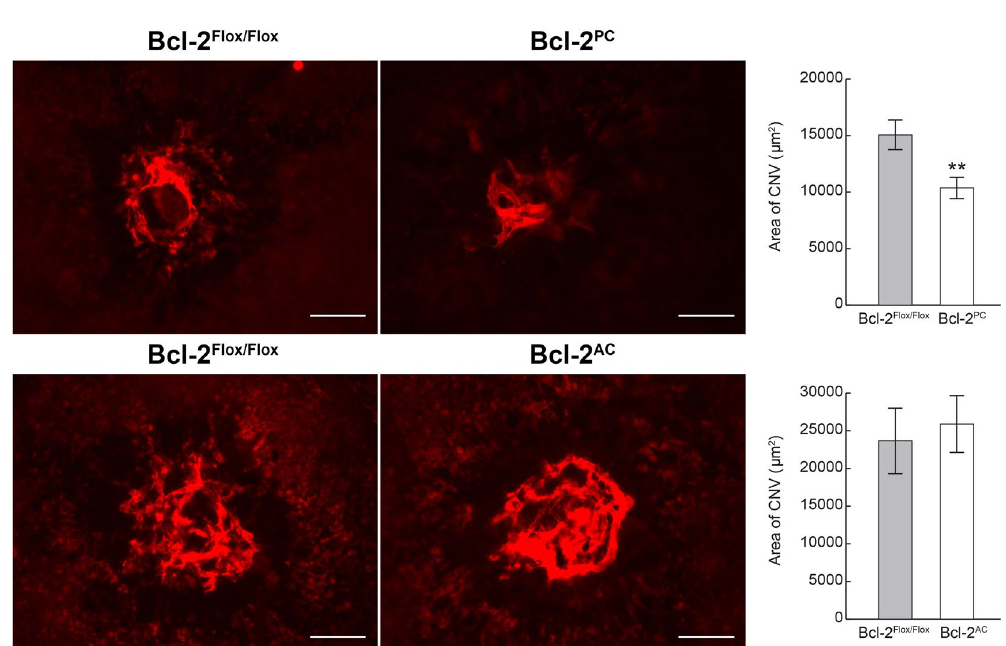
Figure 8. Lack of Bcl-2 expression in pericytes attenuates choroidal neovascularization. Six-week old mice underwent laser photocoagulation-induced rupture of Bruch’s membrane and 14 days later the eyes were sectioned at the equator. The anterior half/vitreous/retina was removed and the remaining eye tissue stained with anti-ICAM-2. The intensity of staining of the area of neovascularization was quantified using Image J ( ** P < 0.01; n = 10). Scale bar = 100 µ